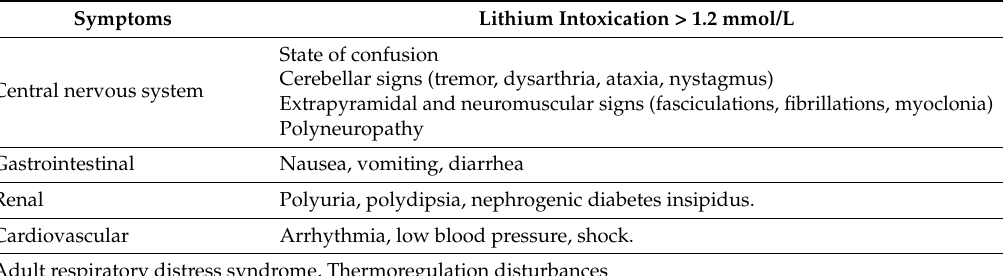
Table 2. Signs and symptoms of lithium